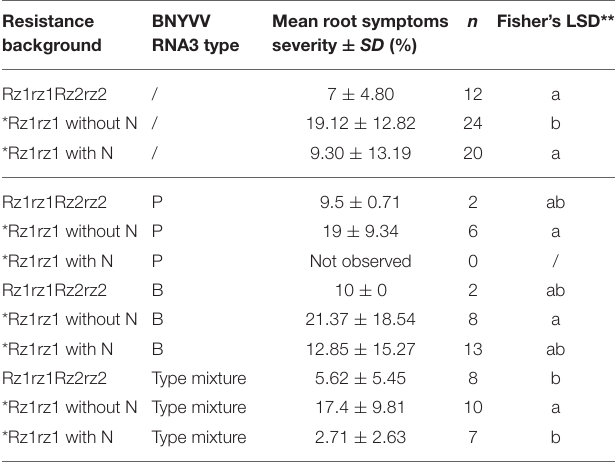
TABLE 5 | Root symptoms severity for Beet necrotic yellow vein virus resistance cultivars grown in France. Resistance background